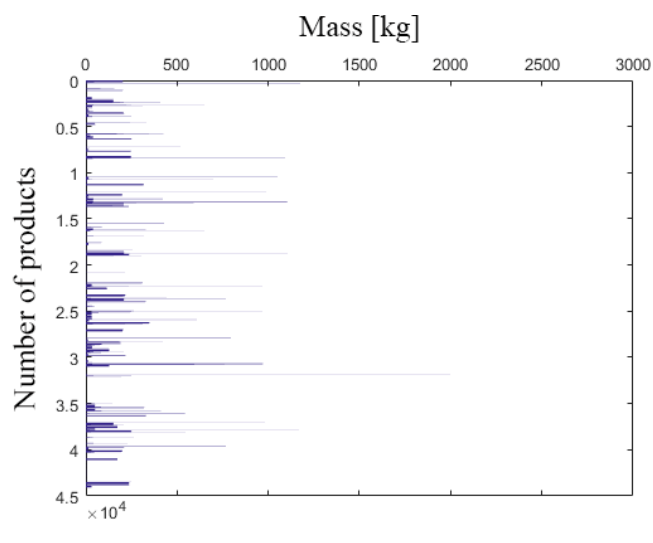
Figure 5. Simulation of all products.